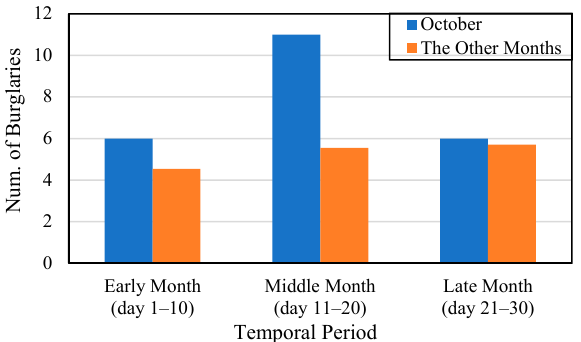
Figure 9. The intra-month variations of burglary in October and the other months in 2010. After the National Day holiday, potential offenders with stronger motivation would spend more effort and travel longer to seek opportunities for committing burglaries. Then, more potential offenders living outside of the DP peninsular would be expected to appear in the peninsula. As there are many constraints (e.g., capability, coupling) on individuals’ mobility, the chances of their appearances in the peninsula would not be evenly distributed in space. Considering that offenders organize their movement around activity nodes, it is expected that areas with more POIs would have more offenders and more burglaries. As such, among the four clusters, Cluster A is expected to have the most POIs. An examination of the spatial distribution of POIs (Figure 10) validates this hypothesis, thus adding credibility to our analysis.